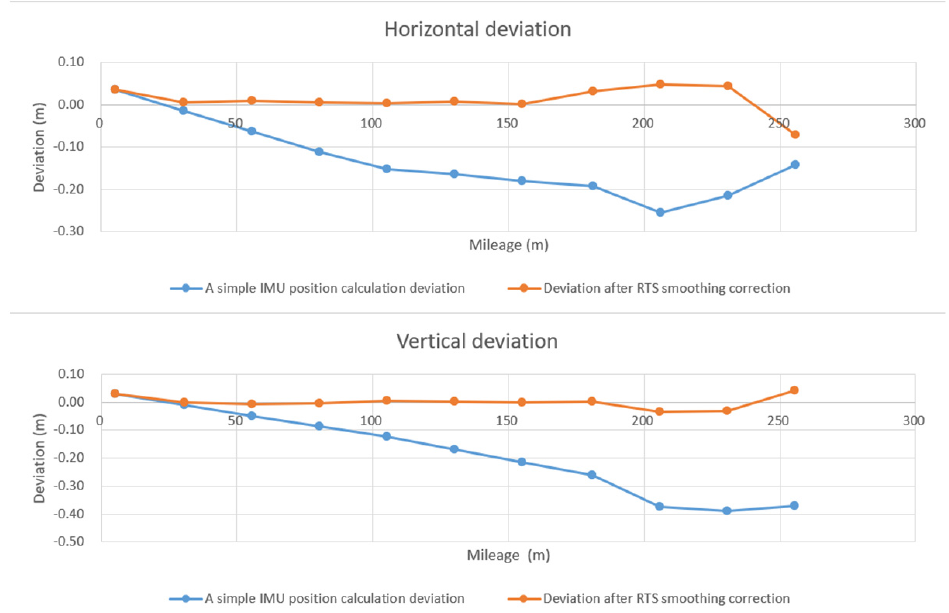
Figure 21. Comparison of trajectory error before and after filter correction.